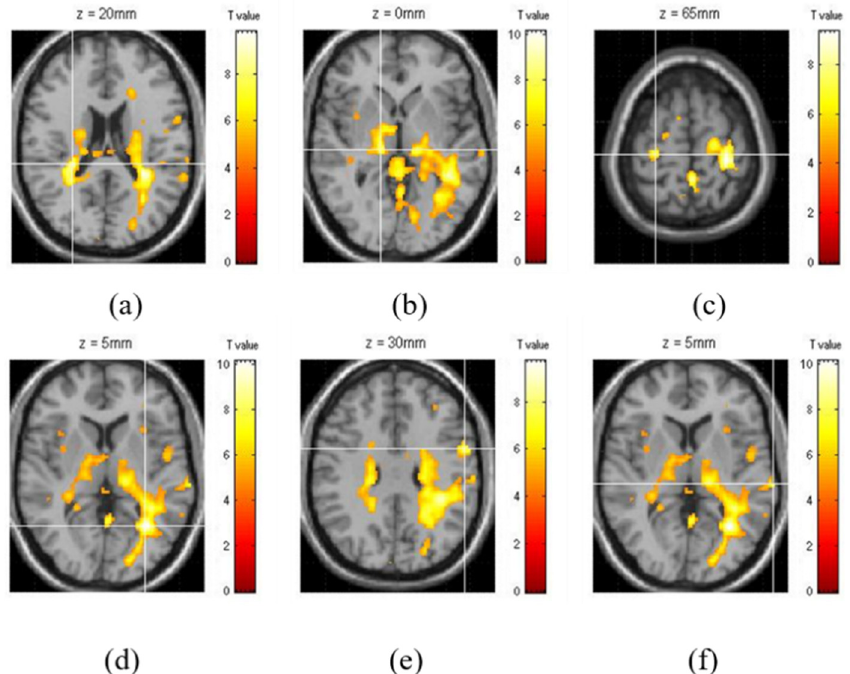
Figure 2. The 3 regions in the right hemisphere with the highest z-scores for the secondary task while driving (white crossbar: each region): the ( a ) insula (Ins), ( b ) thalamus (Th), and ( c ) precentral gyrus (PrG). The 3 regions in the left hemisphere: the ( d ) lingual gyrus (LiG), ( e ) precentral gyrus (PrG), and ( f ) superior temporal gyrus (STG).